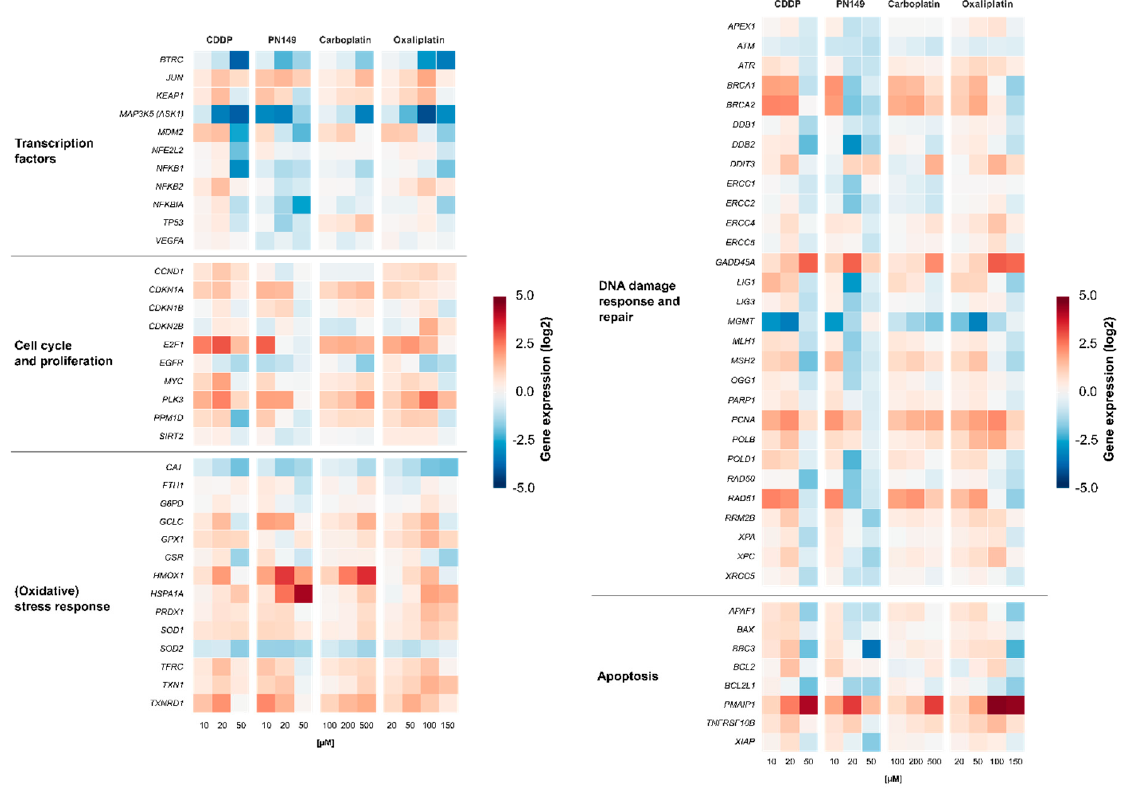
Figure 3. Gene expression profiling after treatment with platinum drugs. ciPTECs were treated with PN149 or cisplatin (10, 20, 50 µM), carboplatin (100, 200, 500 µM) or oxaliplatin (20, 50, 100 and 150 µM) for 24 h. Gene expression was determined by high-throughput RT-qPCR. Genes were grouped into the clusters of transcription factors, oxidative stress response, cell cycle and proliferation, DNA damage response/repair and apoptosis. Shown are the log2 mean values of three independent experiments normalized to the untreated control, whereby the control equals 0.